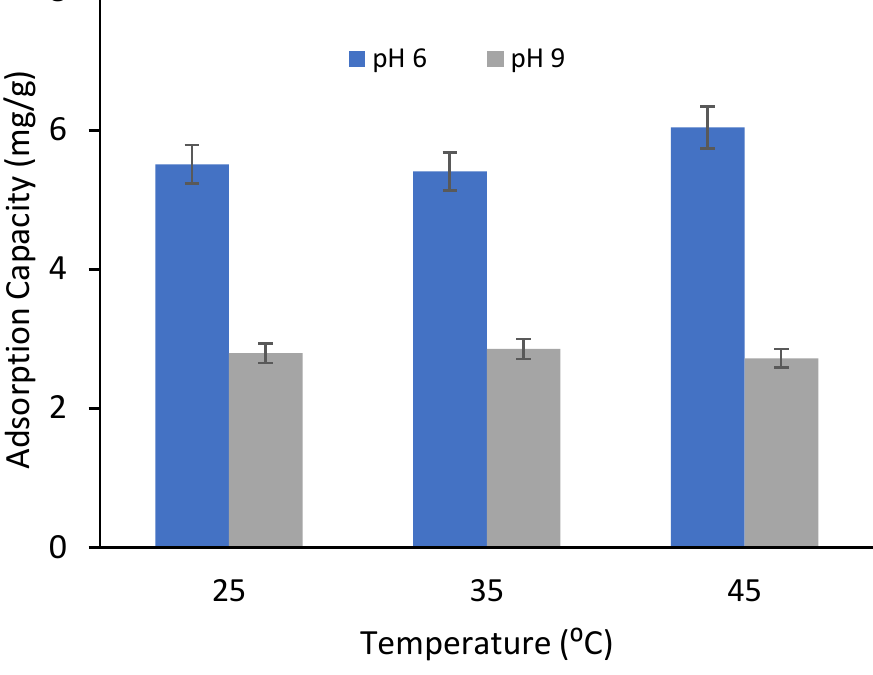
Figure 14. Adsorption capacity of CDC vs. feed solution temperature at pH 6 and 9; CDC loading: 0.6 g/L, agitation speed: 150 RPM.